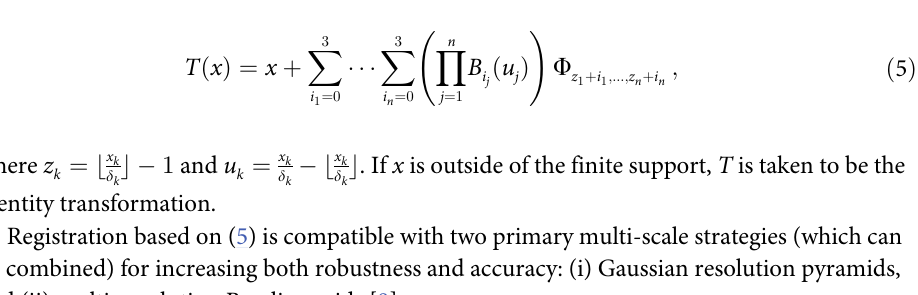
ffiffiffiffiffiffiffiffiffiffiffiffiffiffiffiffiffiffiffiffiffiffiffiffiffiffiffiffiffiffiffiffiffi p p ffiffiffiffiffiffiffiffiffiffiffiffiffiffiffiffi ð i þ 1 Þ 1 þ 1 þ � � � ð i þ 1 Þ